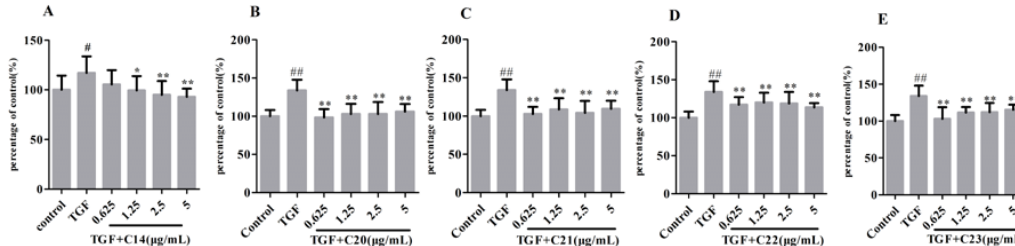
Figure 3. The dose-dependent anti-EMT activities of components 14 ( A ); 20 ( B ); 21 ( C ); 22 ( D ); 23 ( E ) from TMYX. The error bar represent standard deviation based on three repeated. All data was represented by Mean ± SD. Compared to the control, ## p < 0.01, # p < 0.05. Compared to TGF-stimulated cells, ** p < 0.01, * p < 0.05, n = 12 (single-trial).